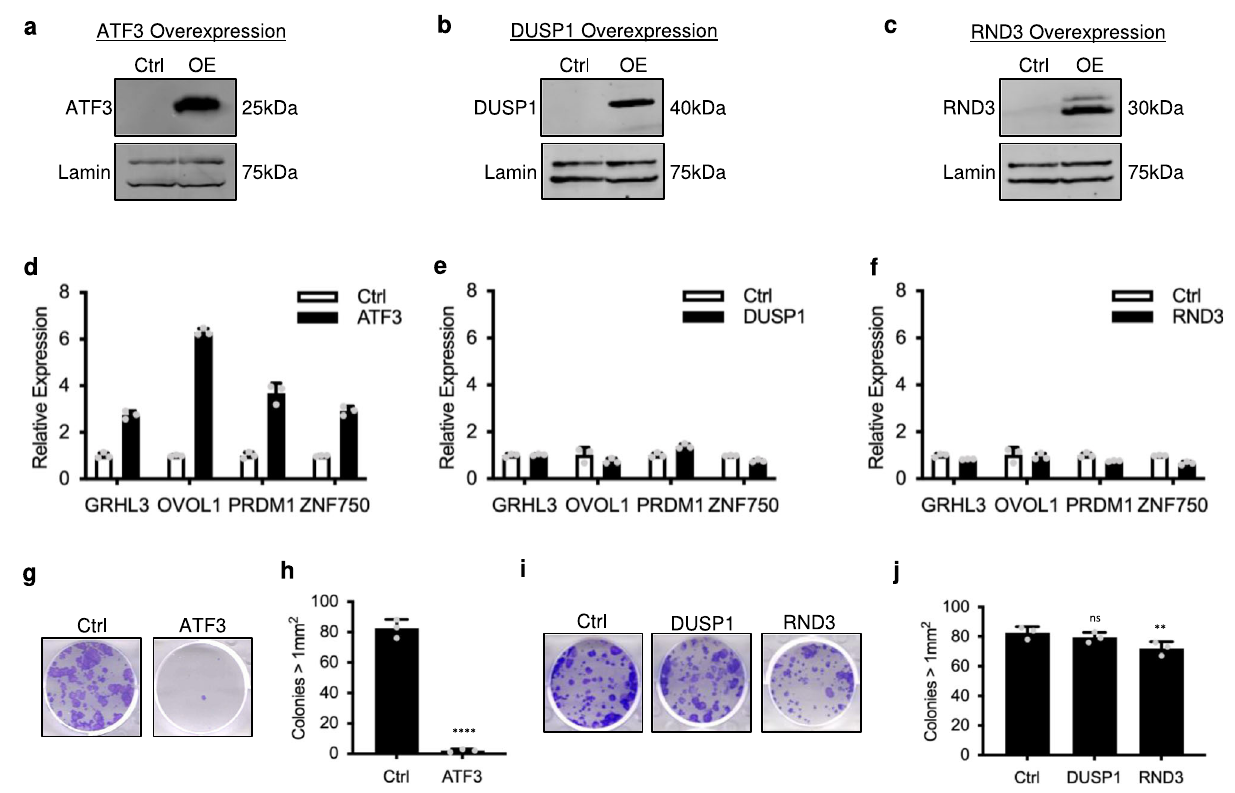
Fig. 6 | The SEC rapid-response gene ATF3 drives keratinocyte differentiation. a – c Western blot showing the overexpression (OE) of ATF3, DUSP1, or RND3 in keratinocytes using the pTRIPZ vector post DOX induction. d – f qRT-PCR showing the mRNA expression levels of differentiation-activating TFs with ATF3, DUSP1, or RND3 overexpression ( n =3 technical replicates, data are presented as mean values±standard deviation). g – j Representative images and quanti fi cation of